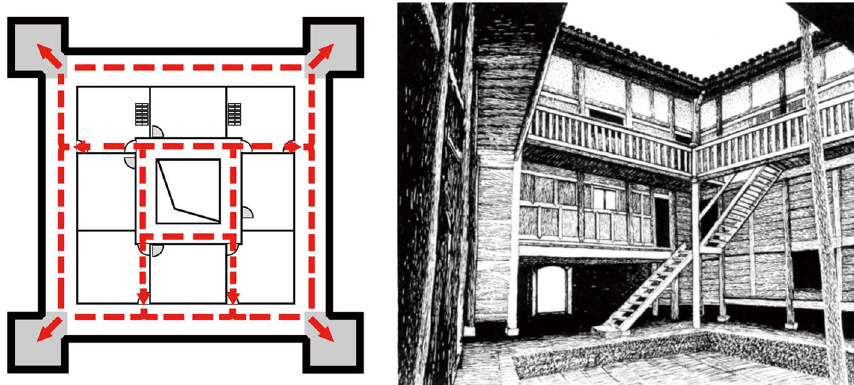
Fig. 1 Chongqing rammed earth watchtower house, which integrated defence and a spatial combination of residences connected by corridors and stairs. Left: the diagram (Source: the author). Right: a view from the courtyard (Source: Ji 2007,